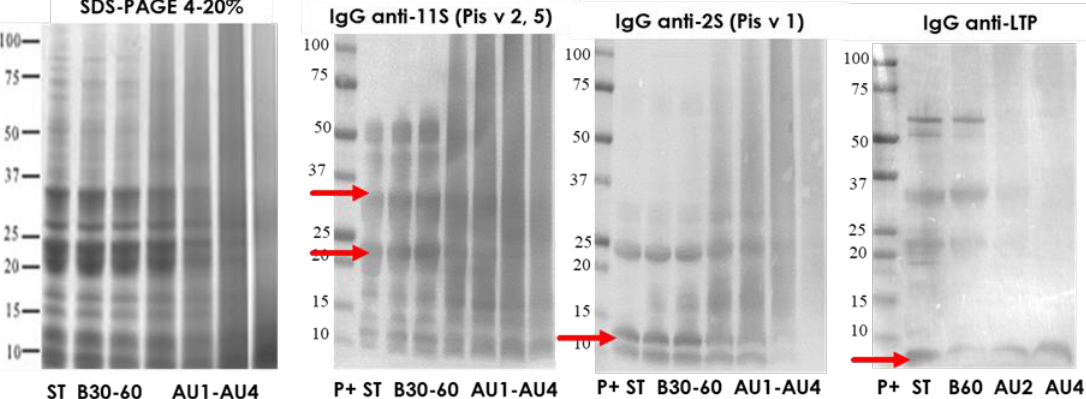
Figure 2. SDS-PAGE and IgG anti-11S, anti-2S, and anti-LTP immunoblots analysis of control (ST), boiled 30 and 60 min (B30, B60) and autoclaved at 121°C 15 and 30 min (AU1, AU2) and 138 °C,